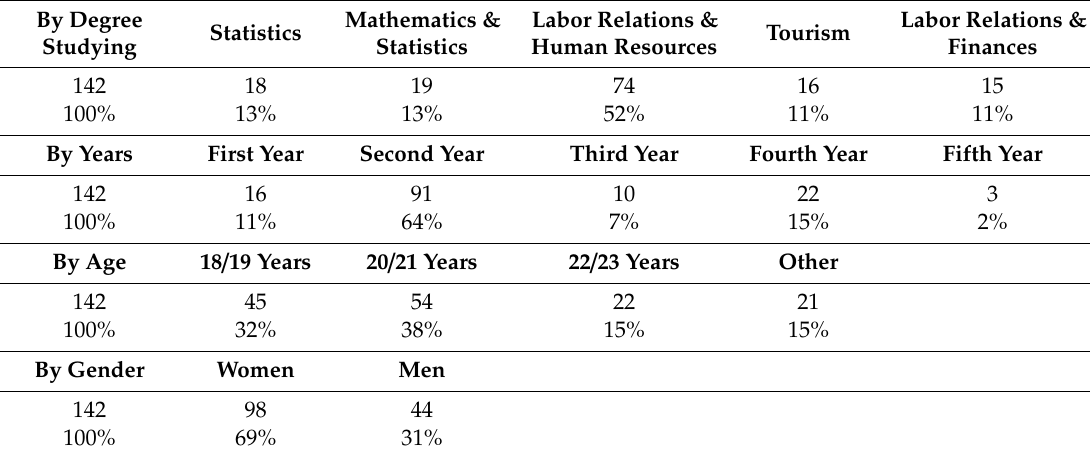
Table 3. Sociodemographic characteristics of BugaMEP registered gamers questionnaire sample Univ. Sevilla. All students of economic courses in di ff erent degrees, year 2017 /